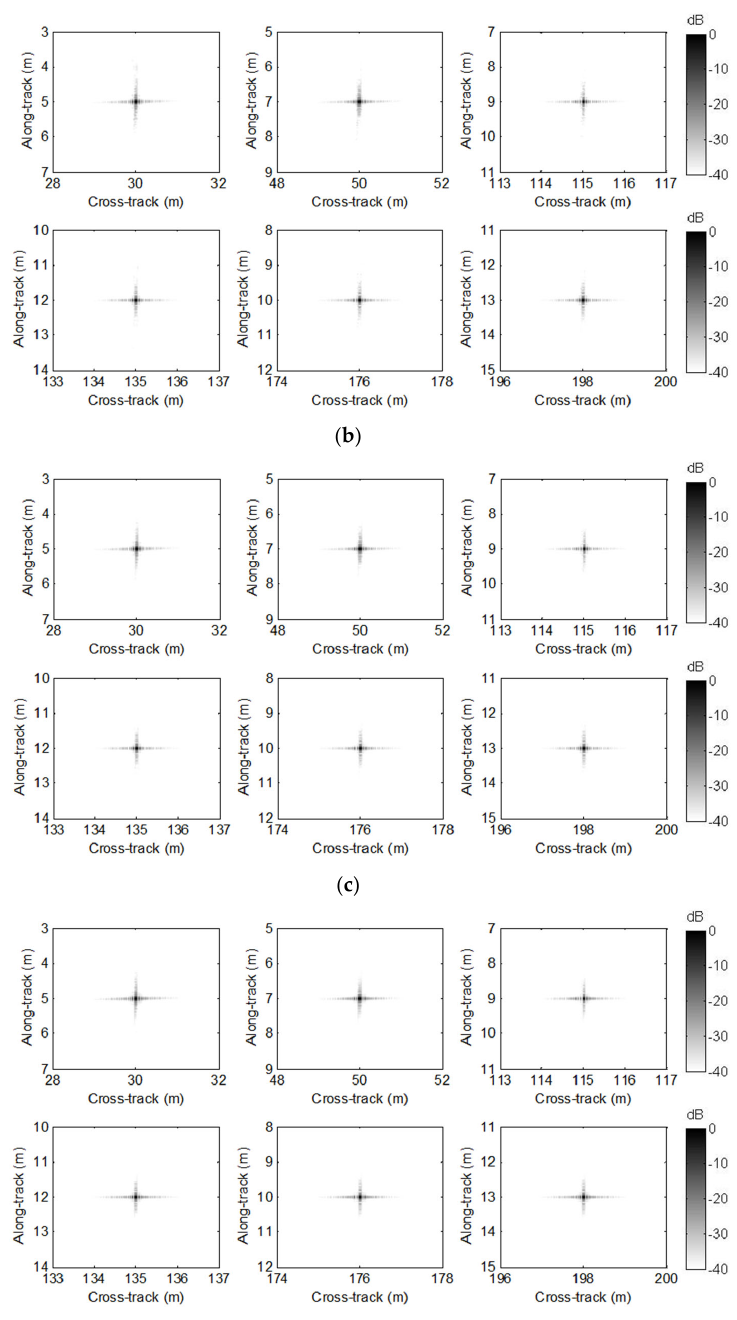
Figure 8. Imaging results with simulated data. ( a ) Nearest − neighbor interpolation without up- sampling operation; ( b ) presented method with upsampling rate of 2; ( c ) presented method with upsampling rate of 8; ( d ) traditional BP algorithm.